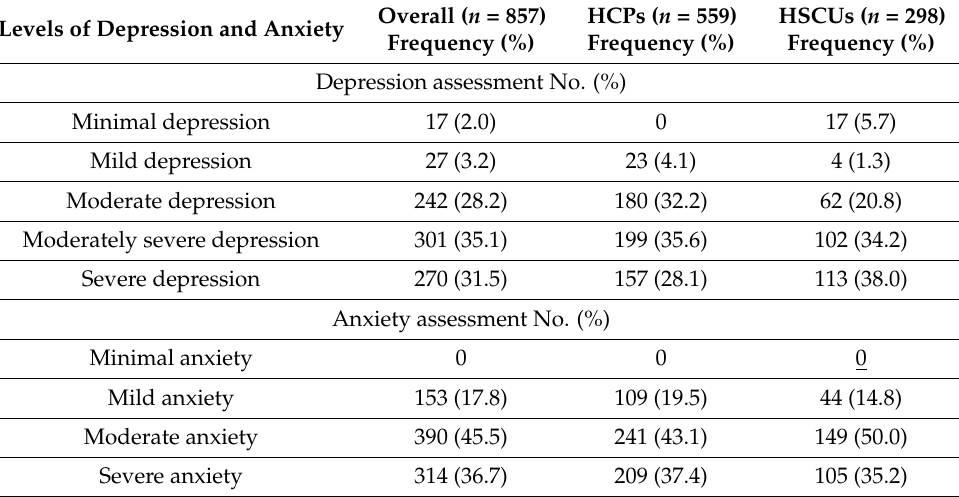
Table 2. Prevalence of depression and anxiety among the participants stratified by severity.